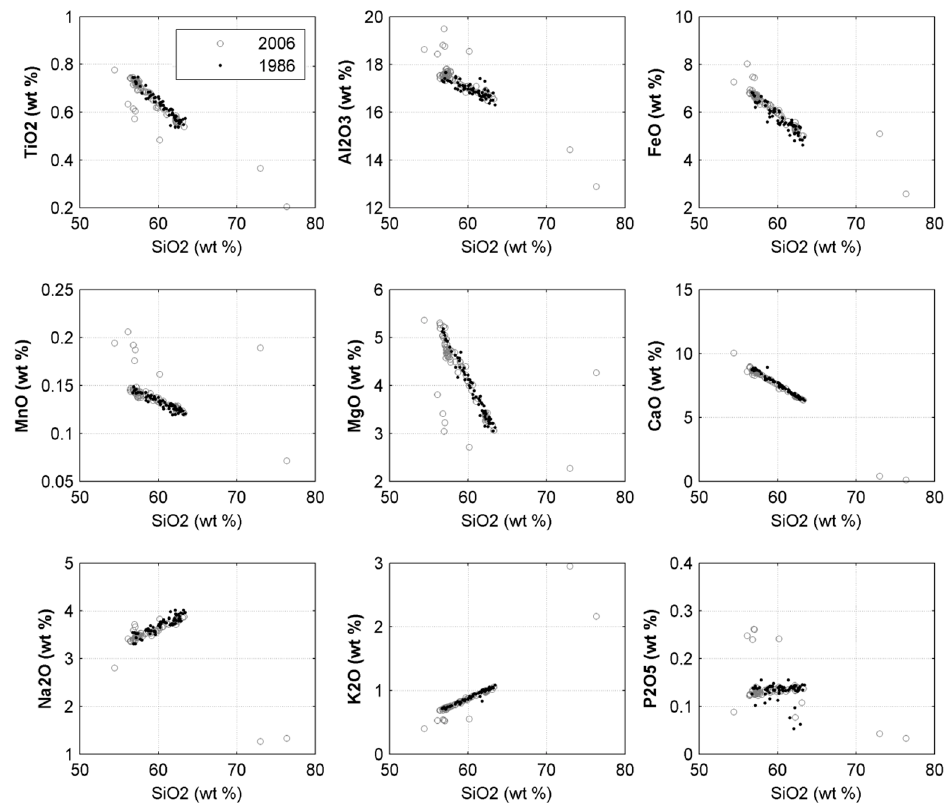
Figure 3. Silica variation diagrams demonstrating general similarities of whole-rock, major element composition in pyroclastic material from Augustine’s 1986 and 2006 eruptions.